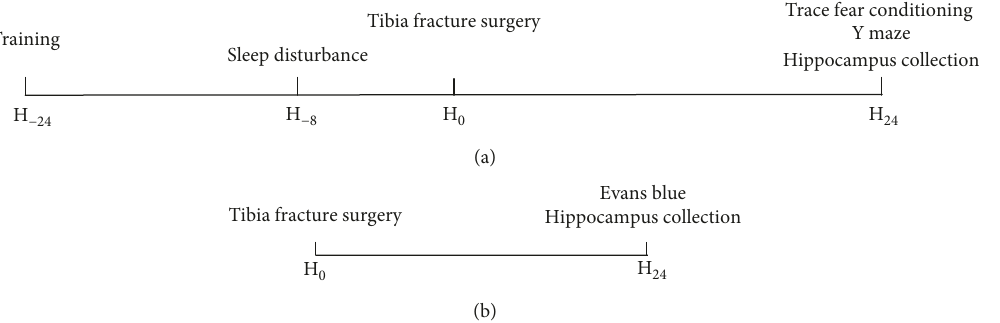
Figure 1: Study design. (a) Experiment 1: the training phase of the trace fear conditioning test was performed 1 day before surgery; afterwards, all mice were divided into four groups. Sleep disturbance lasted for 8h before tibia fracture surgery. All mice underwent the trace fear conditioning and Y maze tests 24 h after surgery, after which the hippocampus was collected. (b) Experiment 2: after the behavioural tests, intravenous injection of EB was performed and the hippocampus was collected to detect EB